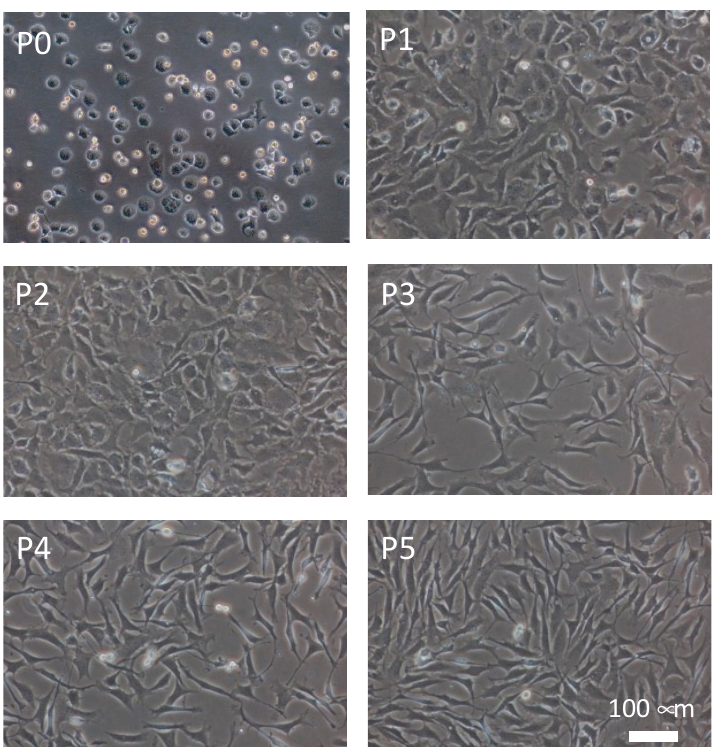
Figure 7. Phase-contrast microscopic images of primary chondrocytes (P0) and de-differentiated chondrocytes passaged for up to five times (P1–P5).